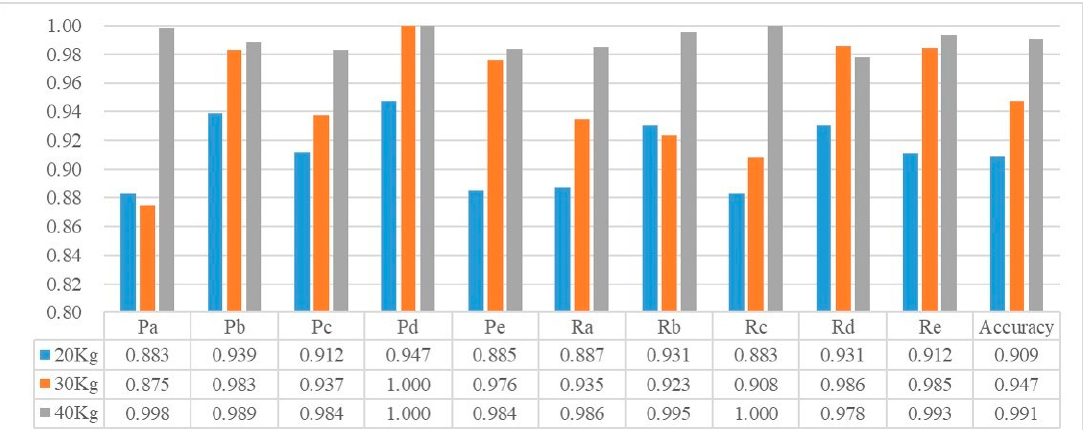
Figure 11. Results of the relationship between weight groups and performance metrics (precision, recall, and accuracy).